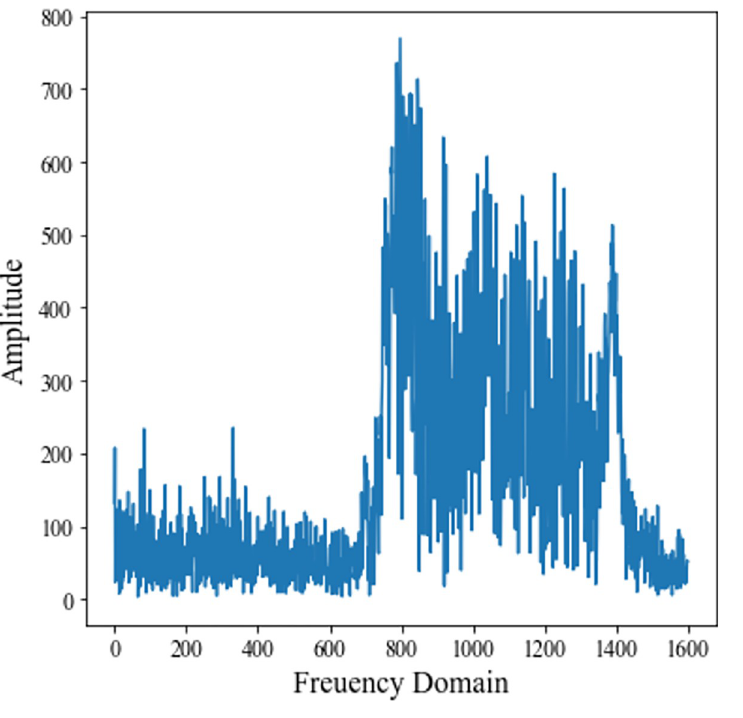
Fig 20. Frequency domain beam data for target.